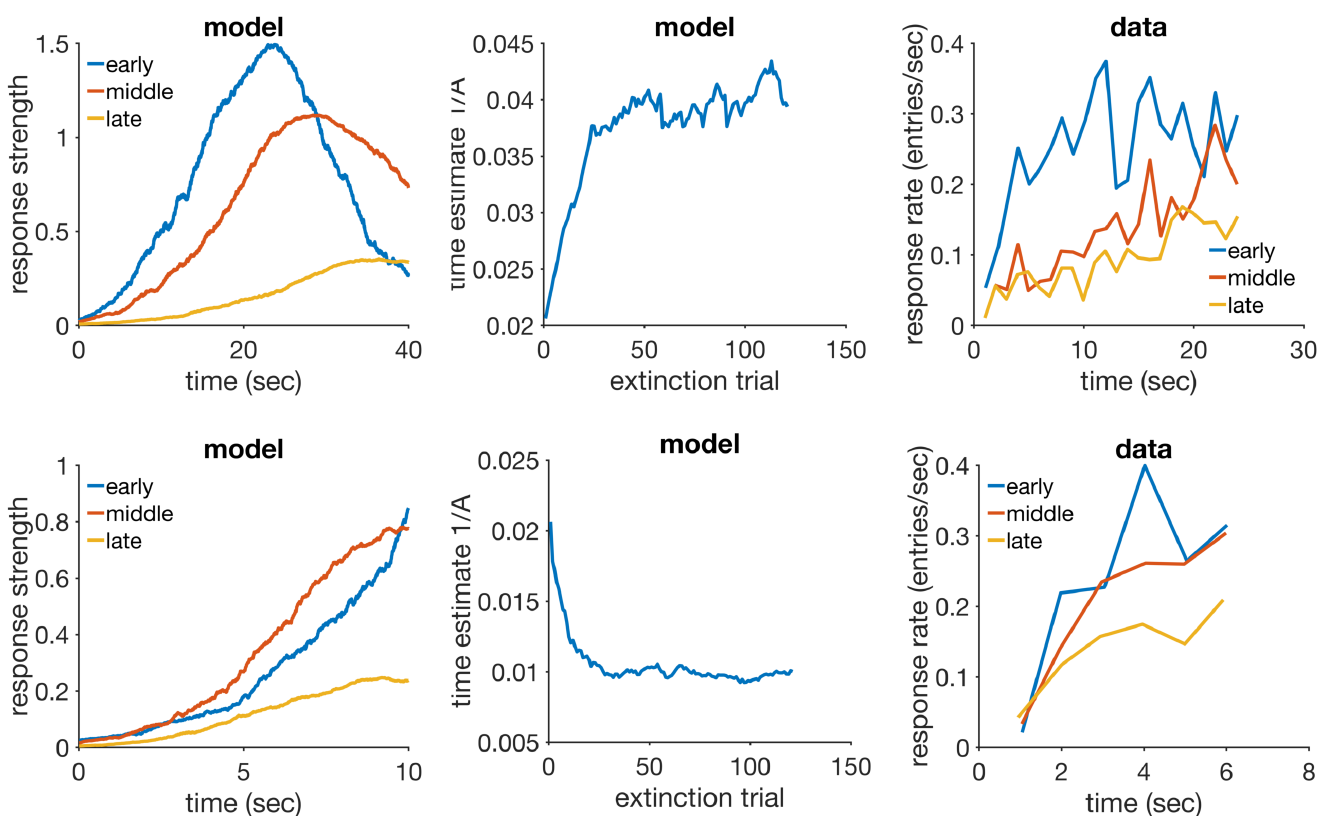
Fig 4. Time change in extinction. Left column: simulatedresponsestrength averaged over trials in extinctionshort-long(top) and long-short (bottom). Middle column: time estimate adaptation of the model duringextinctionshort-long (top) and long-short(bottom). Right column: experimental data from an experiment where the CS durationchangedfrom 12-sec in acquisitionto either 24-sec (top) or 6-sec (bottom) in extinction. Data plots redrawn from Figure 10 in [80]. Model parameters: m = 0.25, θ = 1, σ = 0.35, α t = 0.08, α V = 0.09, H = 30.